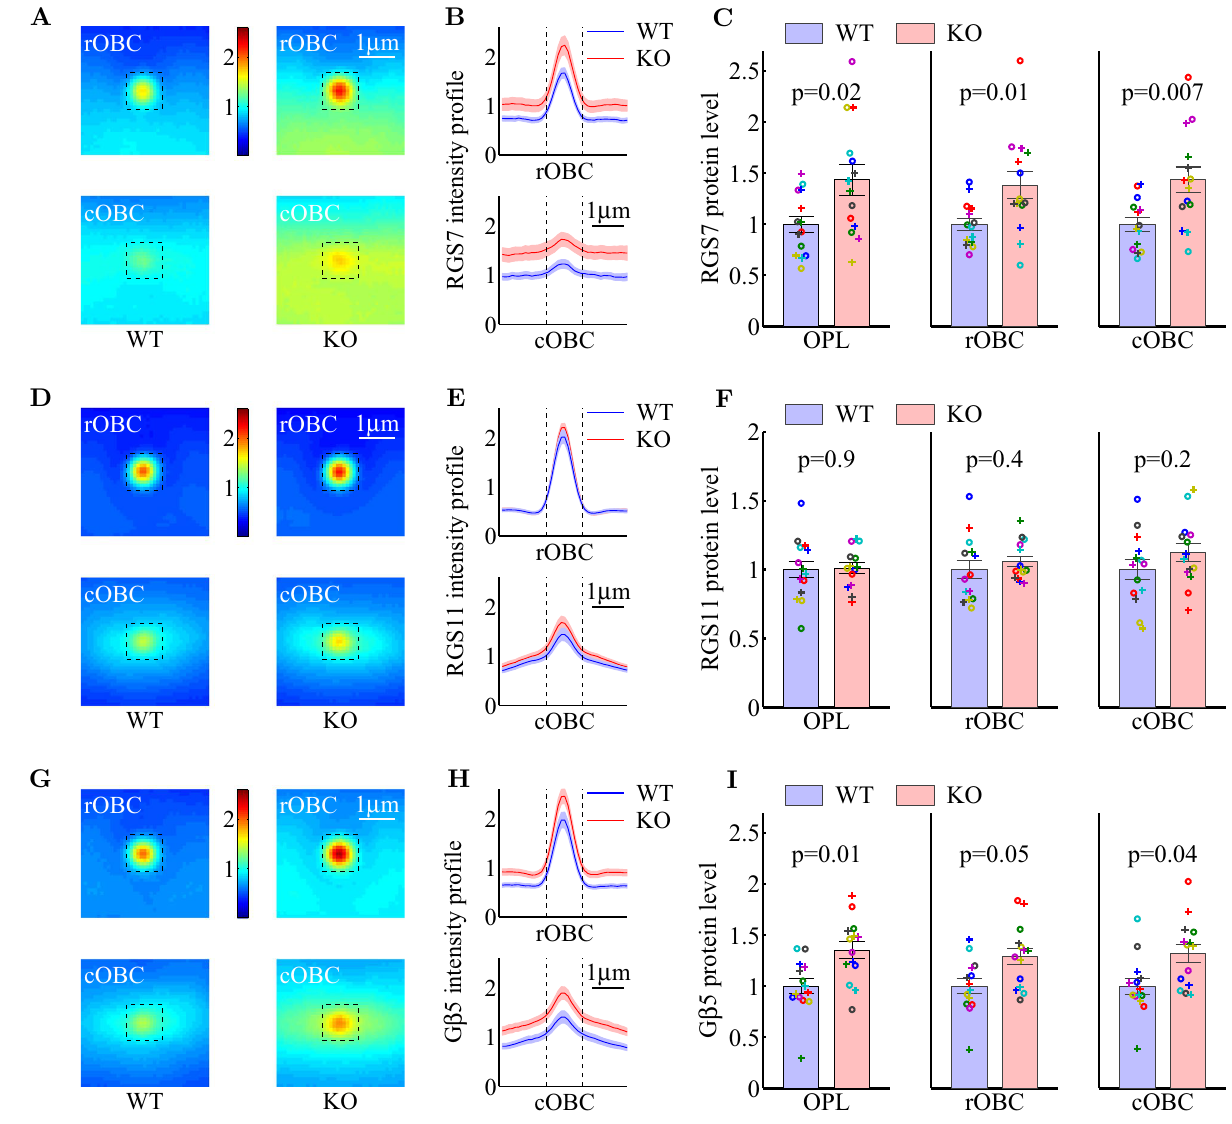
Figure 5. RGS7 and G β 5 protein levels specifically increase in the post-synaptic processes of Ate1 KO mice. ( A ) The average RGS7 staining intensities at all the mGluR6 staining maxima of individual puncta and in punctal patches are shown for rod-OBC (rOBC) on the top and for cone-OBC (cOBC) on the bottom, respectively. The intensity profiles over the horizontal mid-line are shown in ( B ). In ( A ) and ( B ), the background-subtracted intensity is in the unit of the background in the corresponding ONL and the dotted lines mark the central 1.1 µ m region surrounding punctal maxima. ( C ) The total sums at the central region show a significant increase of RGS7 proteins in the post-synaptic processes of rod-OBC and cone-OBC as well as OPL (the same as Fig. 4B, replotted here for comparison) of KO mice. ( D – F ) The corresponding RGS11 protein levels in the post-synaptic processes did not change in the OPL or in the dendritic tips of rod-OBC and cone-OBC. ( G – I ) The corresponding G β 5 protein levels also increased significantly. All averages were computed from the same 14 pairs of the retinal sections of WT and KO littermates and the data points from each pair are plotted with a unique symbol in C , F , and I . The p-values are from paired Student’s t-test (n=14) and the error bars represent SEM. The differences between KO and WT were also evaluated with a non-parametric statistical hypothesis test (Fig. S4), which confirmed the conclusions in ( C ), ( F ), and ( I ). For ( C ), ( F ), and ( I ), the KO/WT ratio of protein levels for individual pairs are shown in Fig. 6A and